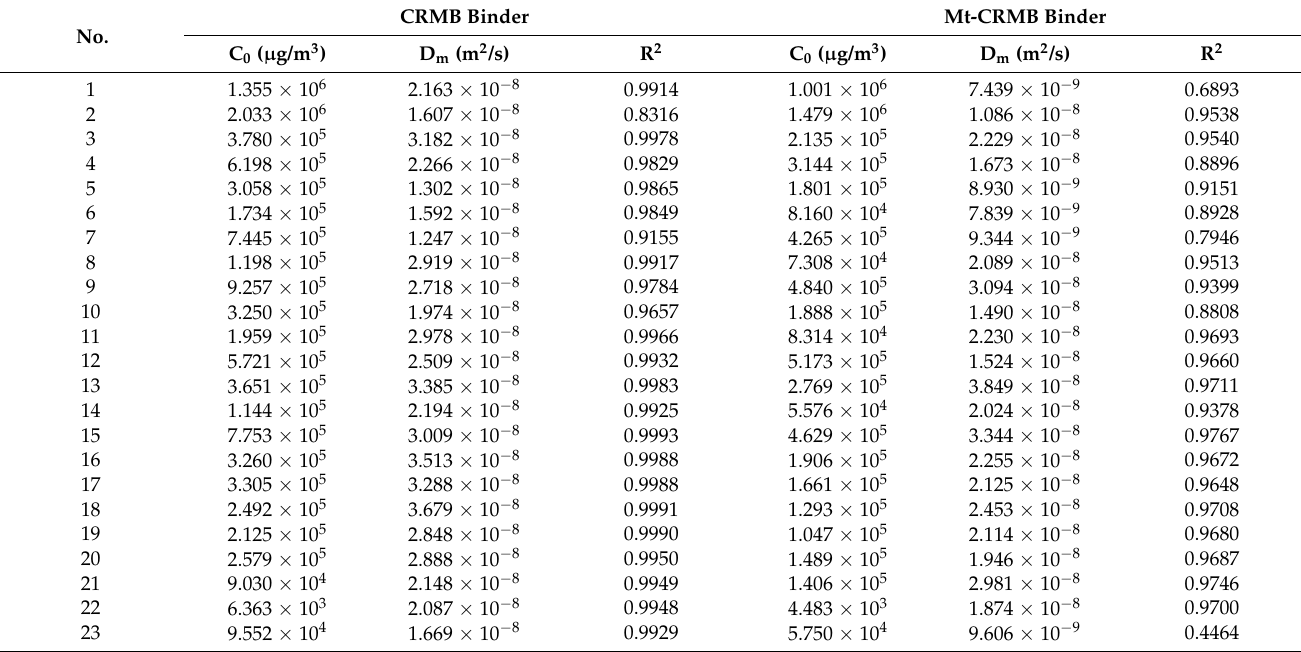
Table 5. The initial concentration, C 0 , and the diffusion coefficient, D m , in the emission model for 23 fingerprint compounds of CRMB and Mt-CRMB